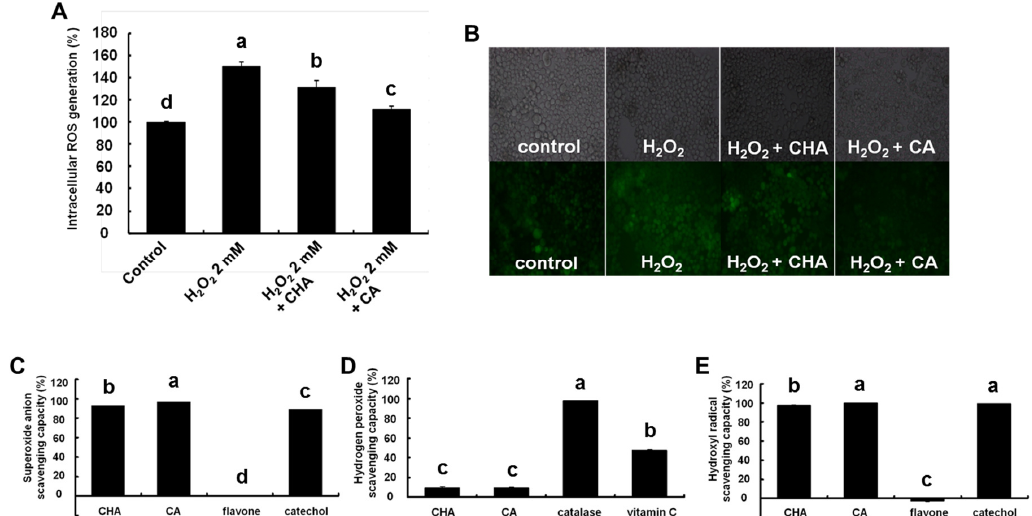
Figure 4. Reactive oxygen species (ROS) scavenging capacity of chlorogenic acid (CHA) and caffeic acid (CA). Caco-2 cells were pre-incubated for 3 h with 1 mM CHA or CA and then 10 µ M H 2 DCFDA was added for 5 min after washing twice with HBSS. Caco-2 cells were exposed to 2 mM hydrogen peroxide (H 2 O 2 ) for 1 h after washing twice with HBSS. ( A ) H 2 DCFDA fluorescence was measured using a plate reader with an excitation and emission wavelengths of 485 and 544 nm, respectively; ( B ) Caco-2 cells cultured on an eight-chambered cover glass were treated under similar conditions, and fluorescence was observed by fluorescence microscopy. Three ROS were observed in cells including ( C ) superoxide; ( D ) H 2 O 2 ; and ( E ) hydroxyl radical. Superoxide produced by xanthine oxidase was detected using a luminometer. H 2 O 2 and hydroxyl radicals induced by Fenton reaction were measured using a microplate reader and luminometer. Catechol, catalase, and vitamin C were used as positive controls, and flavone was a negative control. Values are mean ± SE ( n = 3). Means that have no letter in common are significantly different from each other ( p < 0.05) by Tukey’s test.